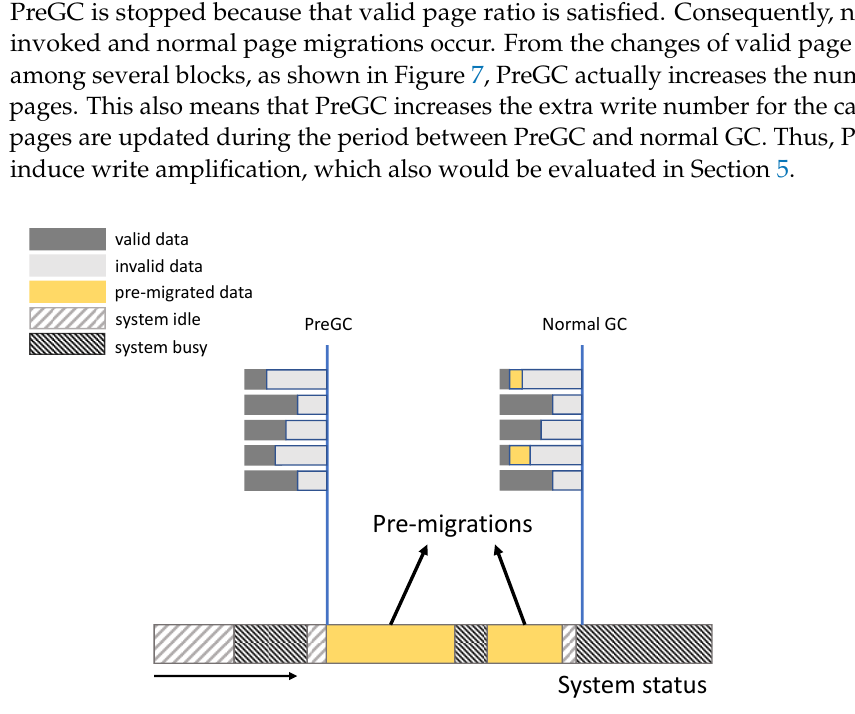
Figure 7. The cooperation between PreGC and normal GC. The box on the lower side of the figure represents the system status progress bar in the SSD, while the box on the upper side represents the page status. The figure shows the system status that will trigger PreGC and Normal GC as well as the current page status and the PreGC process that occurs between